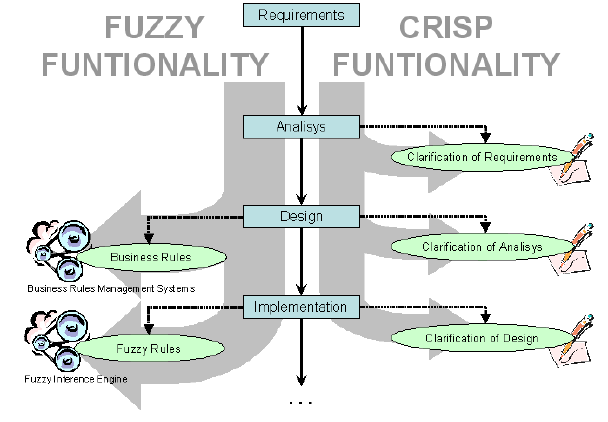
Fig. 1: Methods for fuzzy requirements